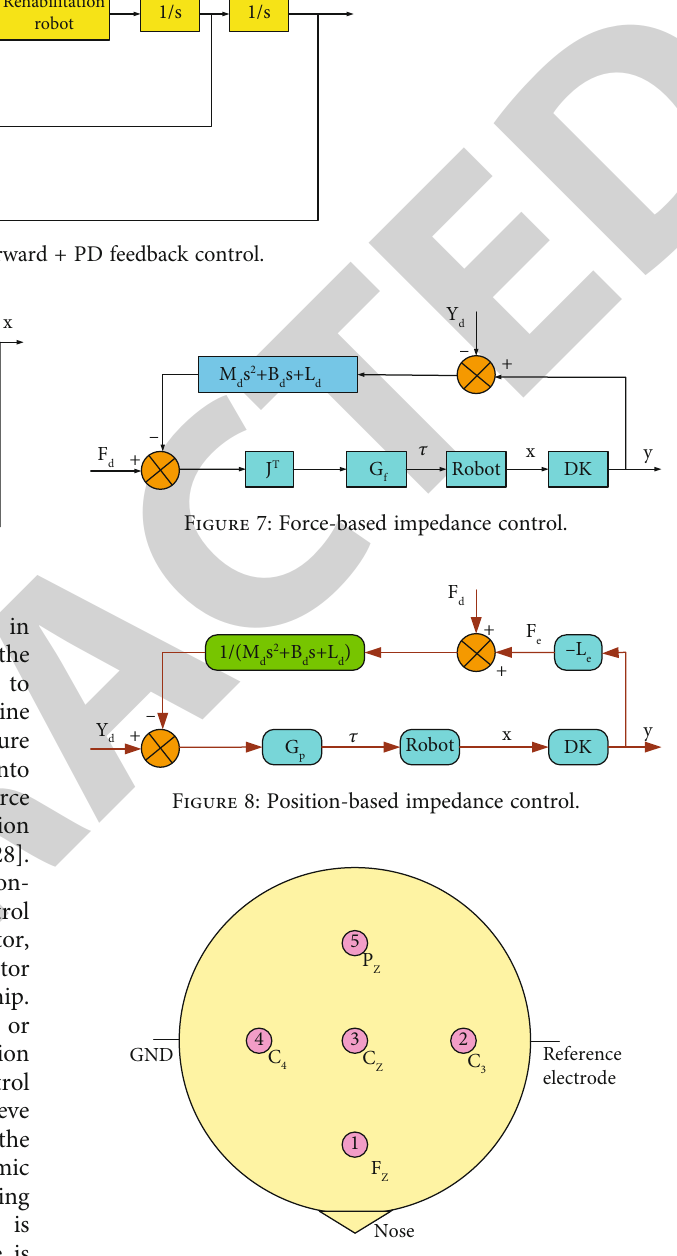
Figure 9: Schematic diagram of electrode positions arranged according to the international 10-20 system